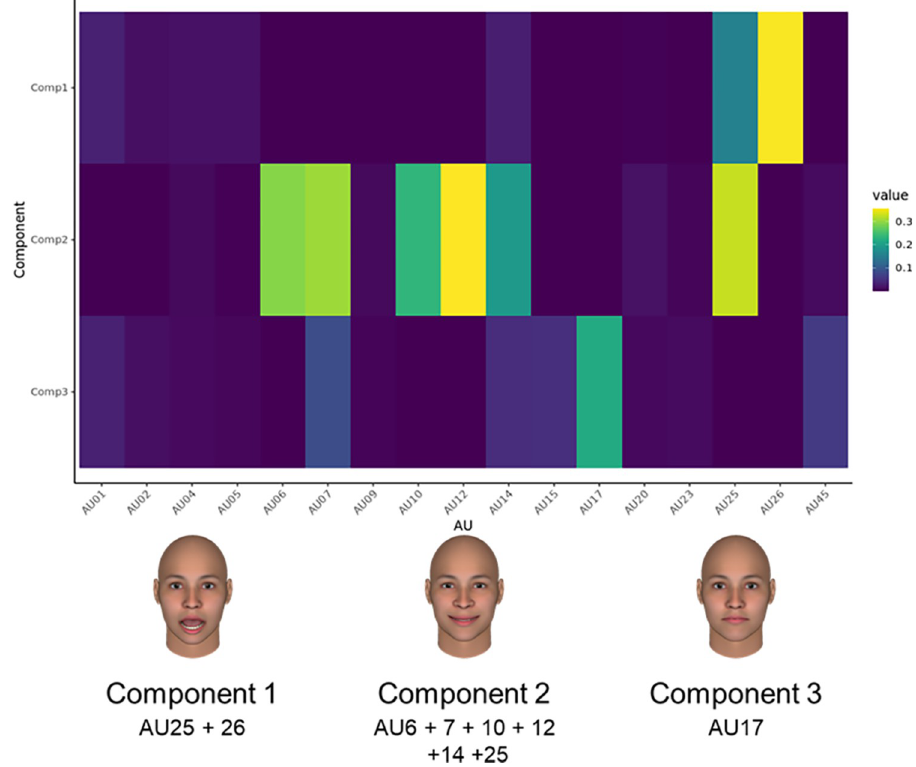
Fig 2. Heatmap of each component’s loadings for facial expressions of happiness (upper part) and visual representations (lower part). Value colors represent each facial movement’s contribution to component scores.